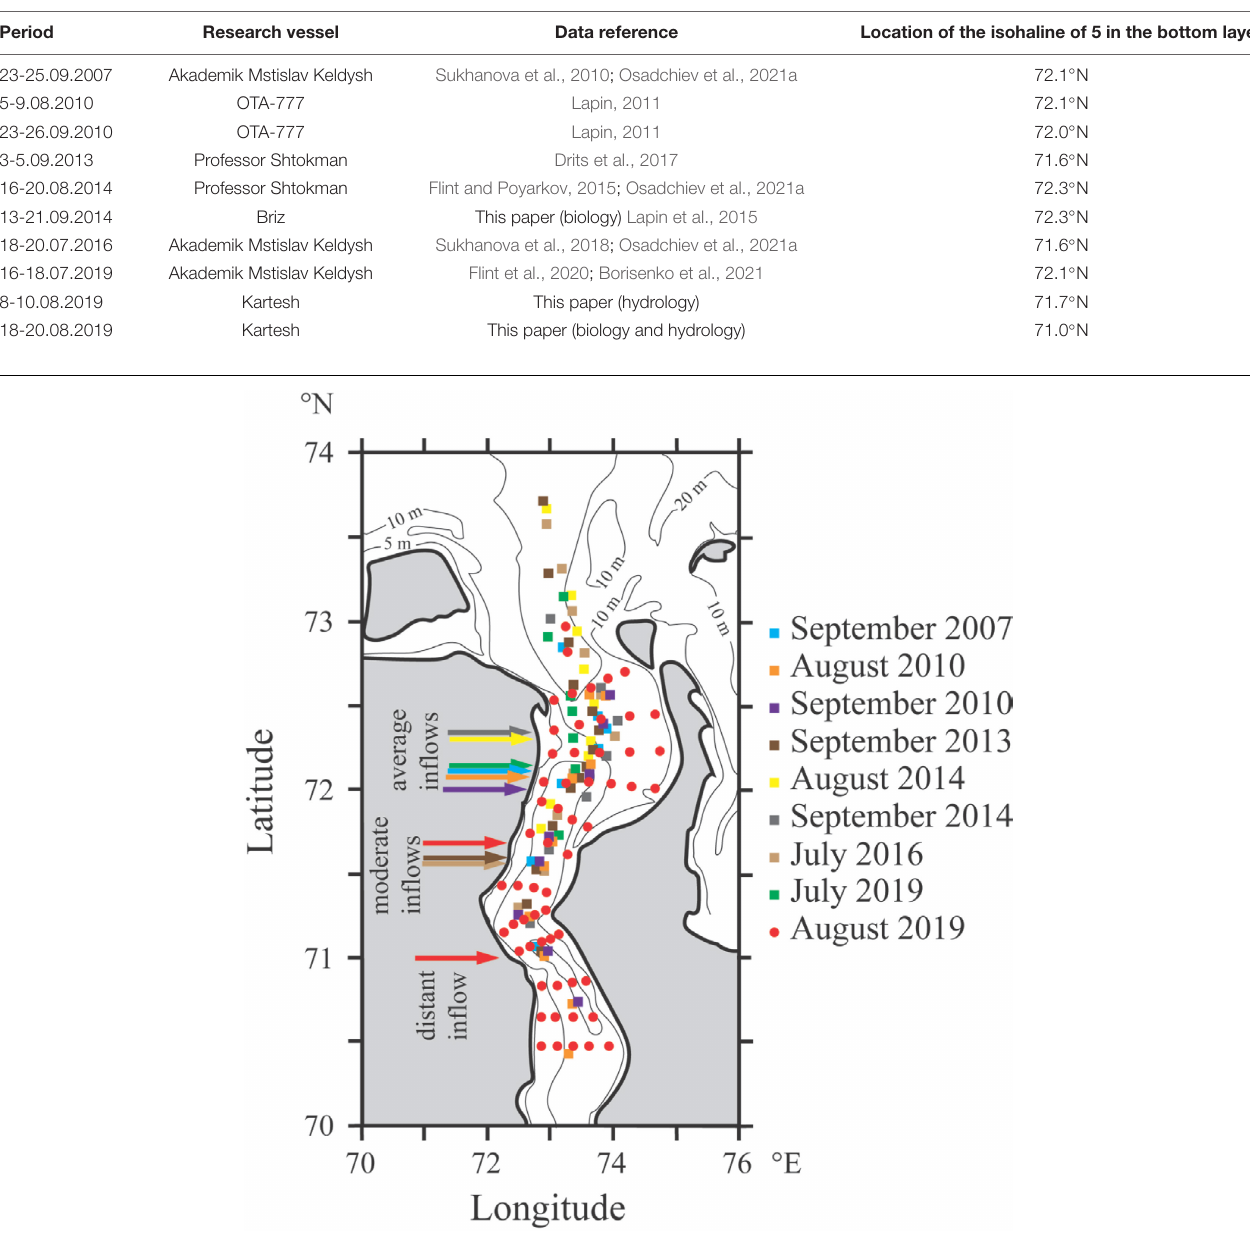
TABLE 1 | Periods, research vessels, and locations of the isohaline of five in the bottom layer during 10 oceanographic surveys in 2007–2019.